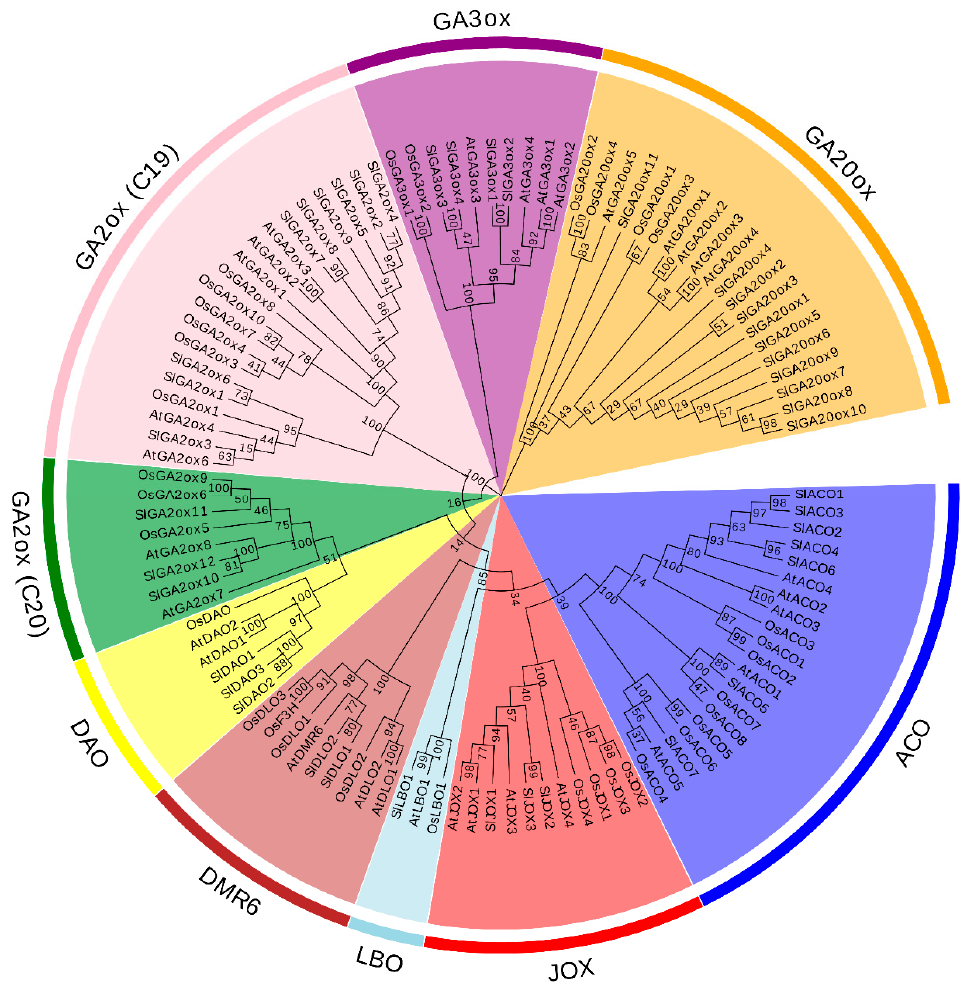
Figure 1. Phylogenetic tree of hormone biosynthetic and metabolism proteins of DOXC family in Arabidopsis , rice, and